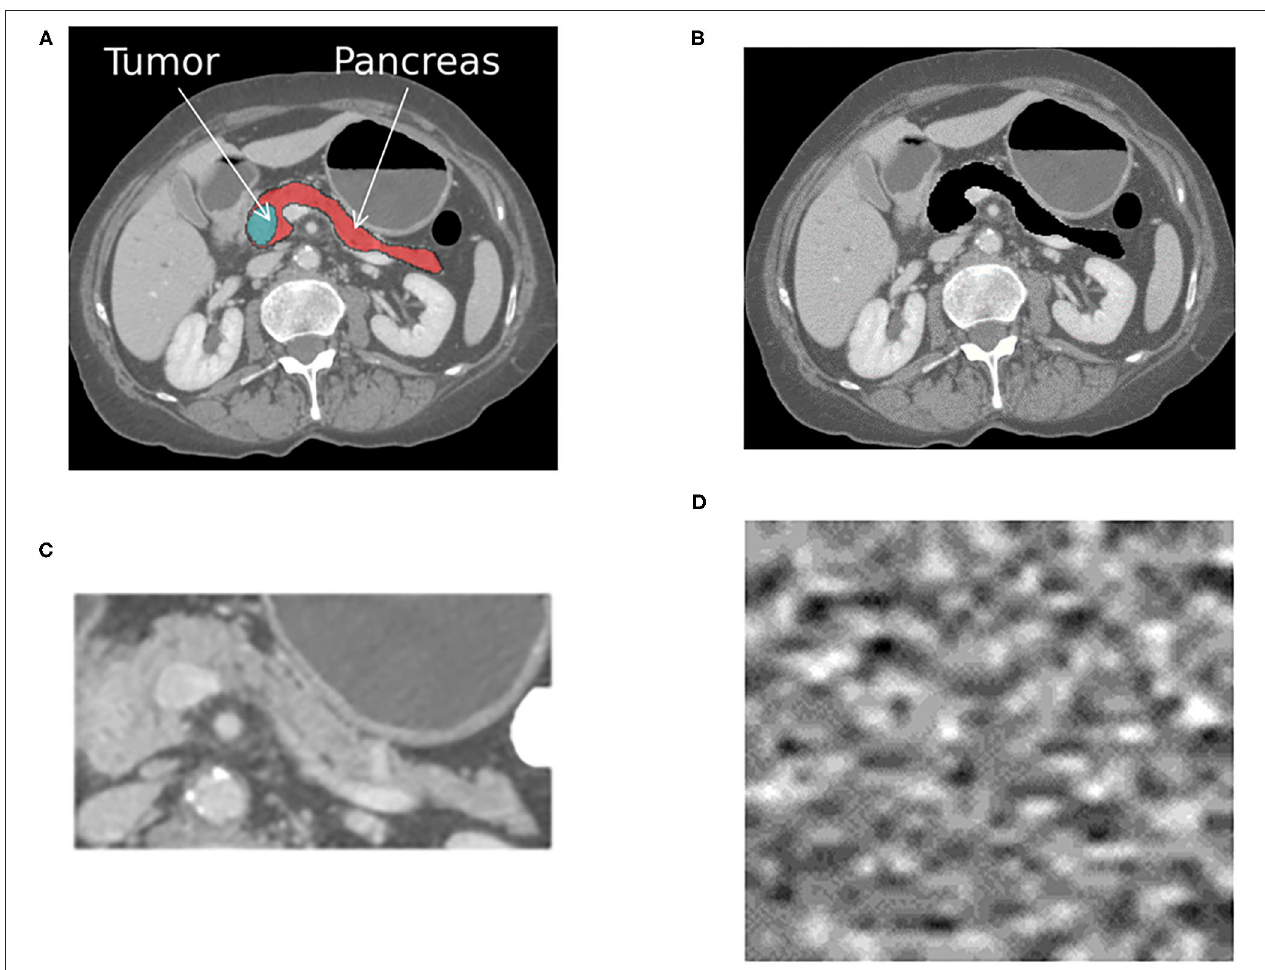
FIGURE 1 | The figure shows an example cross-sectional slice from a single patient with pancreatic cancer that was processed into four different input formats, as shown. A different AI system was trained with each input format, resulting in four different systems that were then tested on each format. (A) The original image with the pancreas and tumor present. (B) The original image with the pancreas and tumor removed. (C) The anatomy surrounding the pancreas is cropped out, and only the pancreas and tumor remain. (D) Noise image generated from the patient CT scans. The same processing was applied to all CT scans within the positive for pancreatic cancer and normal pancreas